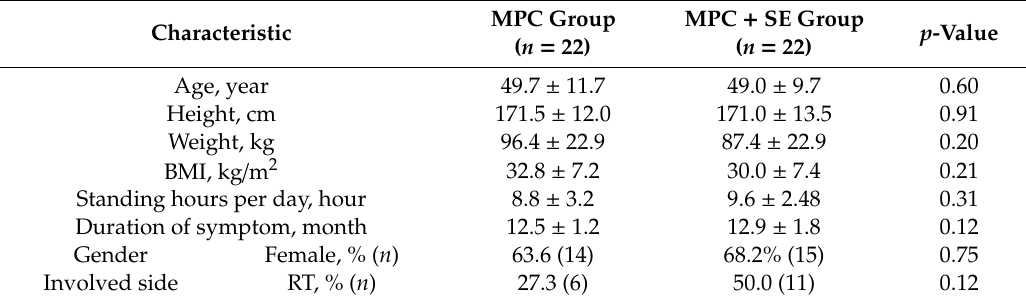
Table 1. General characteristics of subjects ( n = 44).